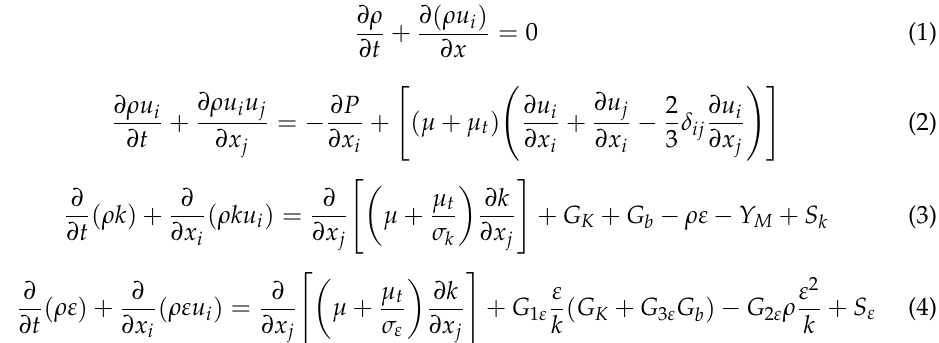
Figure 6. ( a ) Meshed fluid domain; ( b ) magnified view of the mesh. The continuity, momentum, and standard k – ε model equations are expressed in the Cartesian coordinate system in Equations (1)–(4).